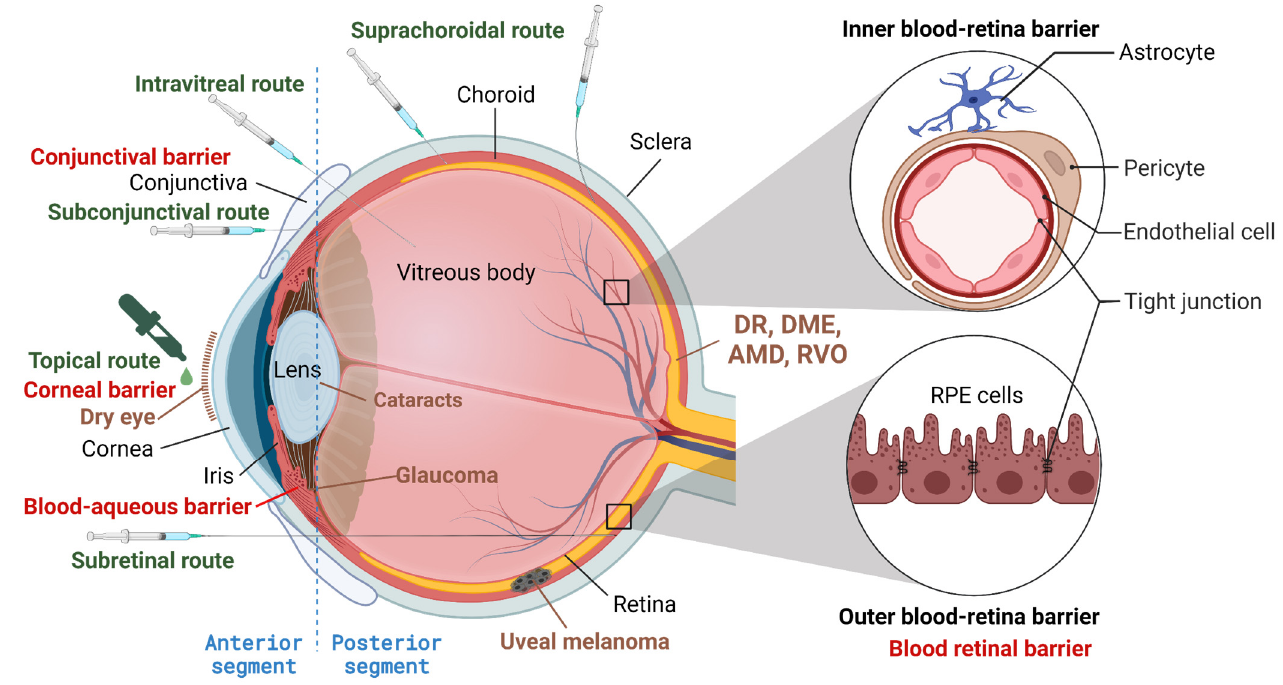
Figure 1. Schemes of the eye structure, common ocular diseases, and ocular drug administration routes. The eye can be divided into an anterior segment and a posterior segment. The anterior segment includes conjunctiva, cornea, anterior and posterior chambers (narrow space behind the iris and in front of the lens). The posterior segment consists of the choroid, retina, and vitreous body. Topical application of ophthalmic formulations is the common route for drug delivery to the anterior segment of the eye for eye diseases that occur at the front of the eye, such as dry eye and glaucoma. Subconjunctival injection can be used for steroid delivery in the setting of ocular inflammation. In contrast, delivery of therapeutic agents to the posterior segment for other eye diseases, including DR, AMD, diabetic macular edema (DME), retinal vein occlusion (RVO), and uveal melanoma, needs invasive administration such as intravitreal, suprachoroidal (microneedle and microcannula), and subretinal injection. Created with BioRender.com.